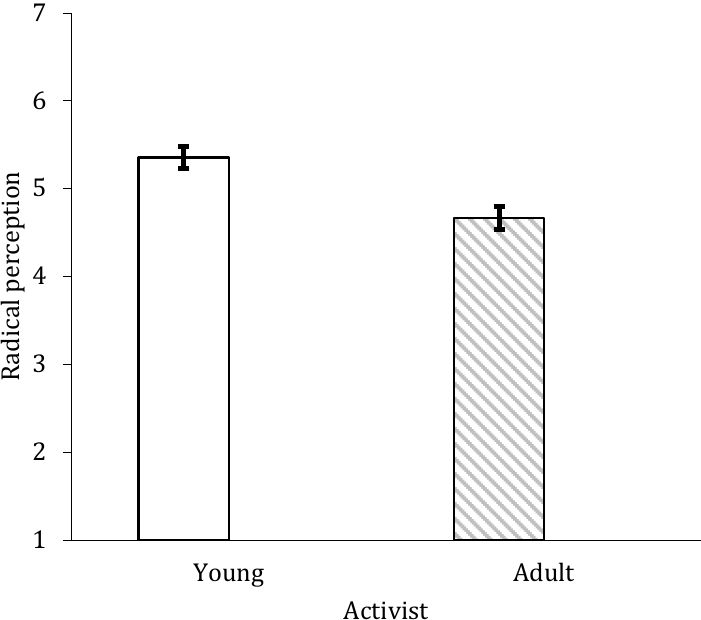
Figure 5. Means and standard errors regarding perceptions of the personalities as radical by experimental conditions.